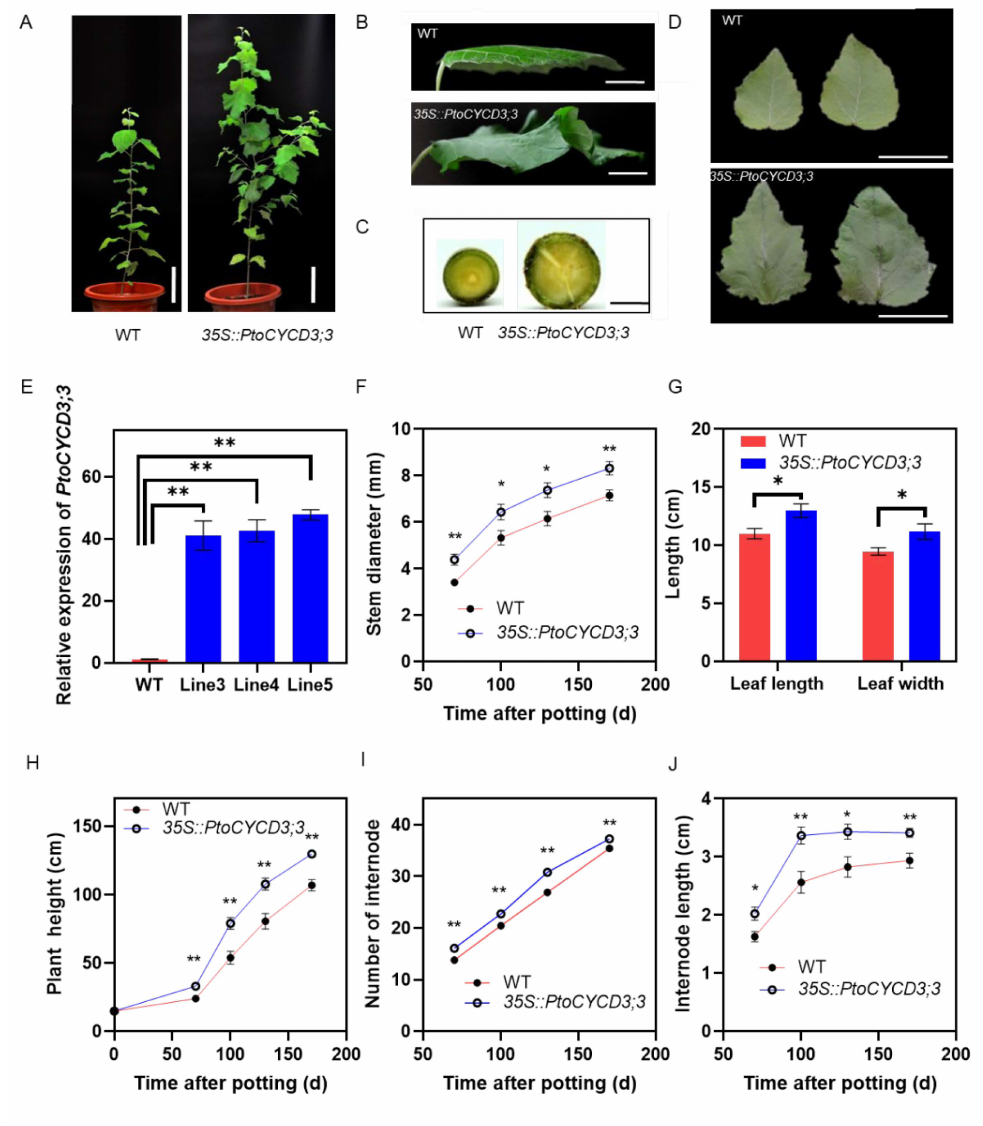
Figure 2. Morphological phenotypes in the overexpression of PtoCYCD3;3 in Populus . ( A ) Whole plants. ( B , D ) Leaf of wild-type (WT) and 35S::PtoCYCD3;3 plants. ( C ) Stems. ( E ) Expression levels of PtoCYCD3;3 in wild-type (WT) plants and three independent lines of 35S::PtoCYCD3;3 plants. The expression in each sample was normalized using Populus Actin (GenBank number XM_002316253) as an internal control. The bars represent the mean SE of three biological replicates. ( F ) Stem diameter. ( G ) Leaf size. ( H ) Plant height. ( I ) Number of internodes. ( J ) Internode length. Significance as determined by independent sample T-test: * p < 0.05, ** p < 0.01. The values are means ± SE, n = 10. Ten transgenic lines were used to measure growth parameters. Each transgenic line used one individual. ( A – C ) The plant age was at 110 days. ( D , E ) The plant age was at 70 days. ( G ) The plant age was at 130 days. Bar, 15 cm ( A ); 2 cm ( B ); 0.5 cm ( C ); 3 cm ( D